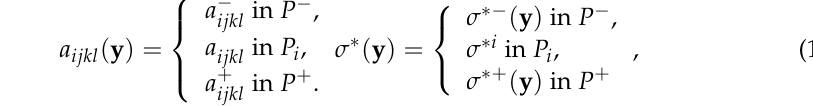
P and define the elastic con- i